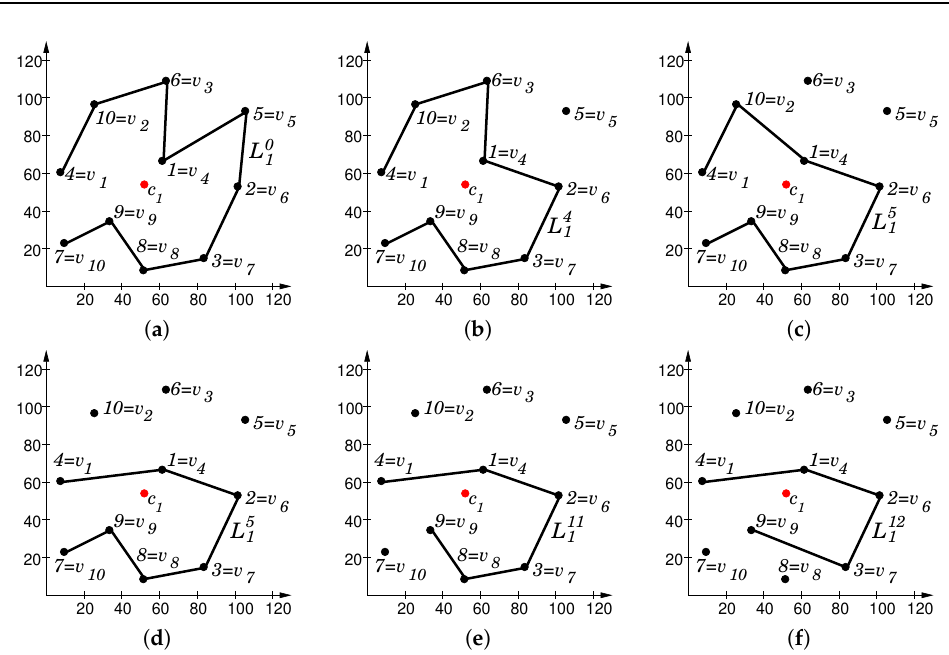
Figure 16. Graphs corresponding to the iterations carried out by Algorithm 5 ( INNER − CONVEX − HULL ) for the construction of the inner convex hull P for the example instance